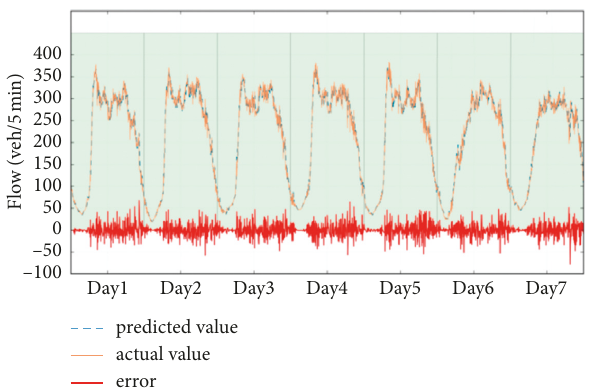
Figure 5: Prediction results from multi-feature fusion model under test set.